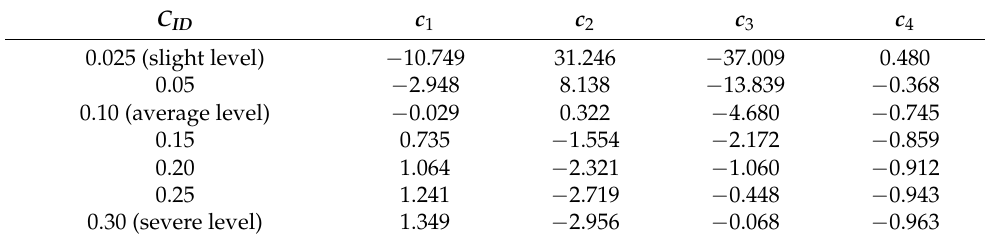
Table 3. Sub-coefficients of IDI obtained with slight level until severe level of